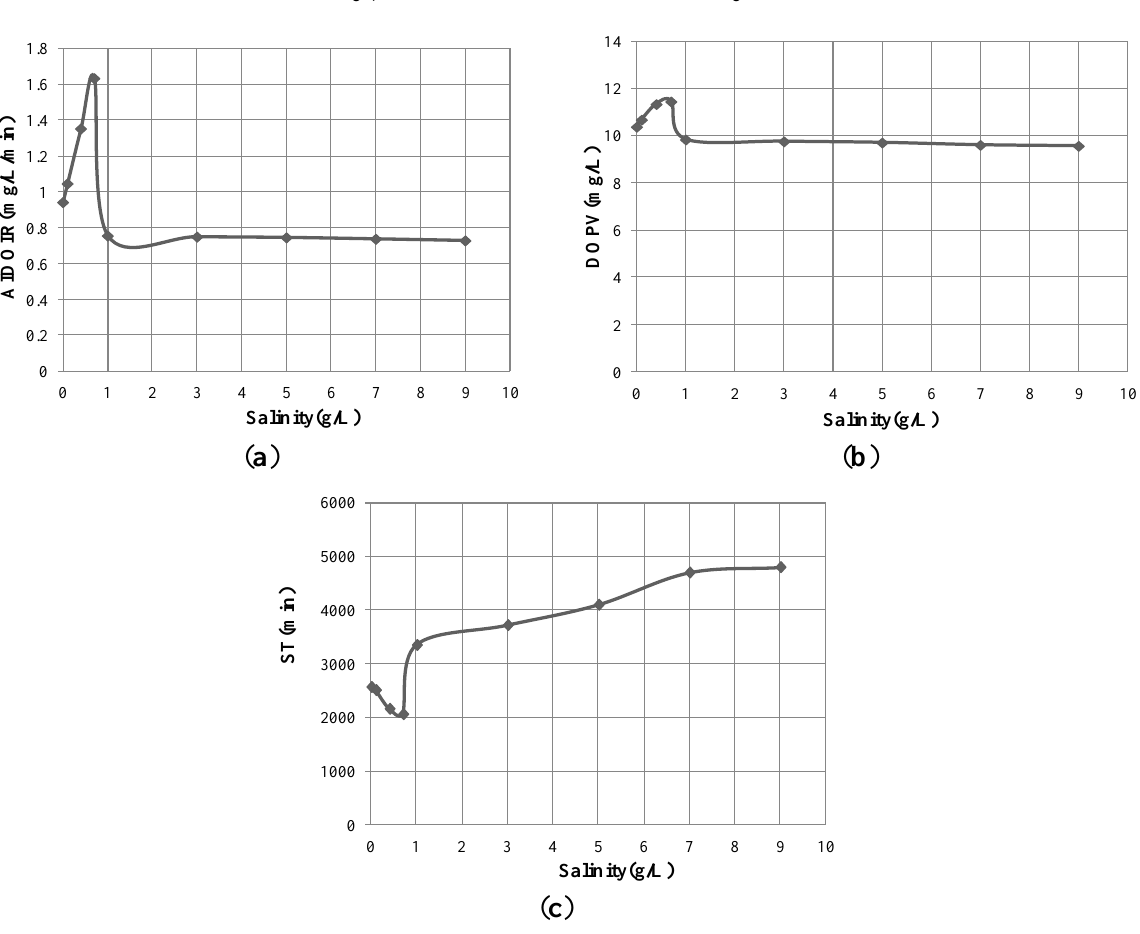
Figure 3. Impact of salinity on oxygen transfer process. ( a ) AIDOIR in different salinity; ( b ) DOPV in different salinity; and ( c ) ST in different